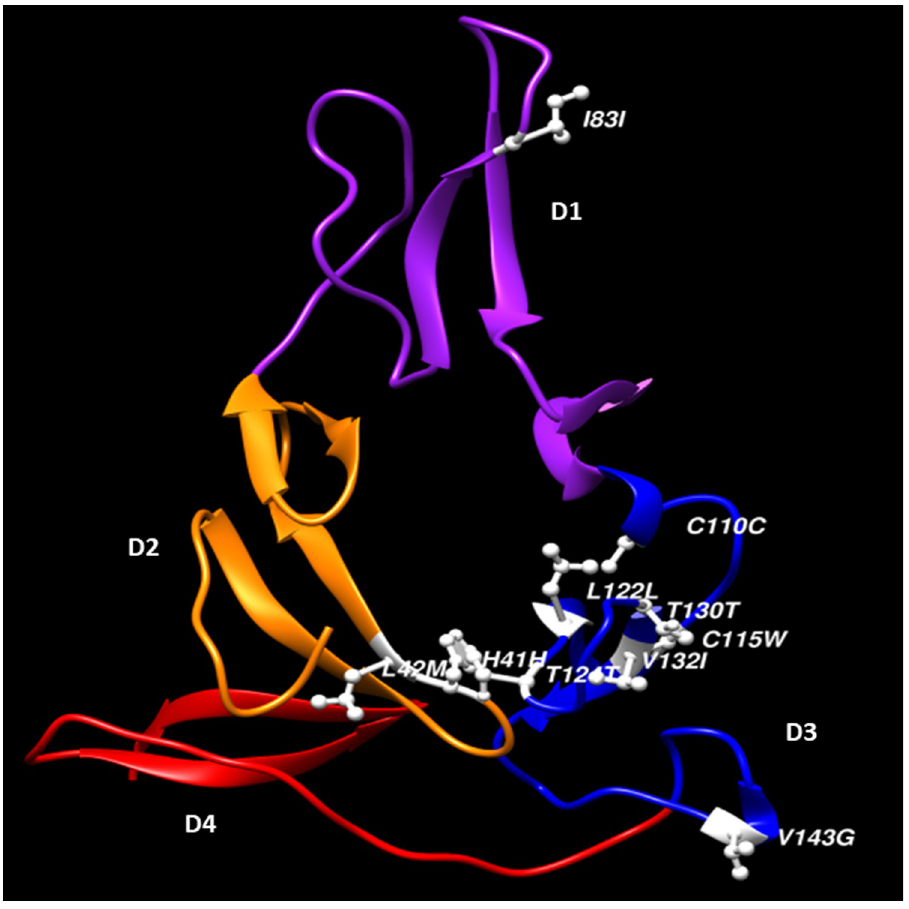
Fig 2. Predicted structure of Pfs25 antigen and distribution of polymorphic codons on its domain 1, 2 and 3. Beta strands ( β ) and loops in orange represent D1; D2 is in purple β -strands and loops; D3 is in blue β -strands and loops whereas D4 is represented by red β -strands and loops. The white balls and sticks represent codons with mutations in the Pfs25 antigen (Molecular graphics and analyses performed with UCSF Chimera, developed by the Resource for Biocomputing, Visualization, and Informatics at the University of California, San Francisco, with support from NIH P41-GM103311).